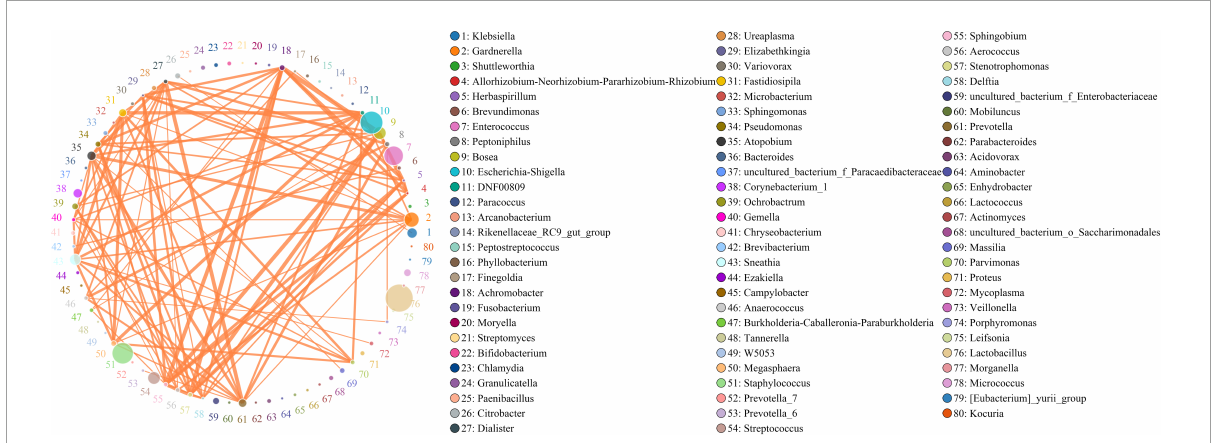
FIGURE4 Microbiota network diagram. The top 50 most relevant genera were shown here. The circle in the figure represents the species, and the size of the circle represents the abundance; the line represents the relation between the two species, the thickness of the line represents the strength of the relation, and the colour of the line: orange represents positive correlation, and the green represents negative